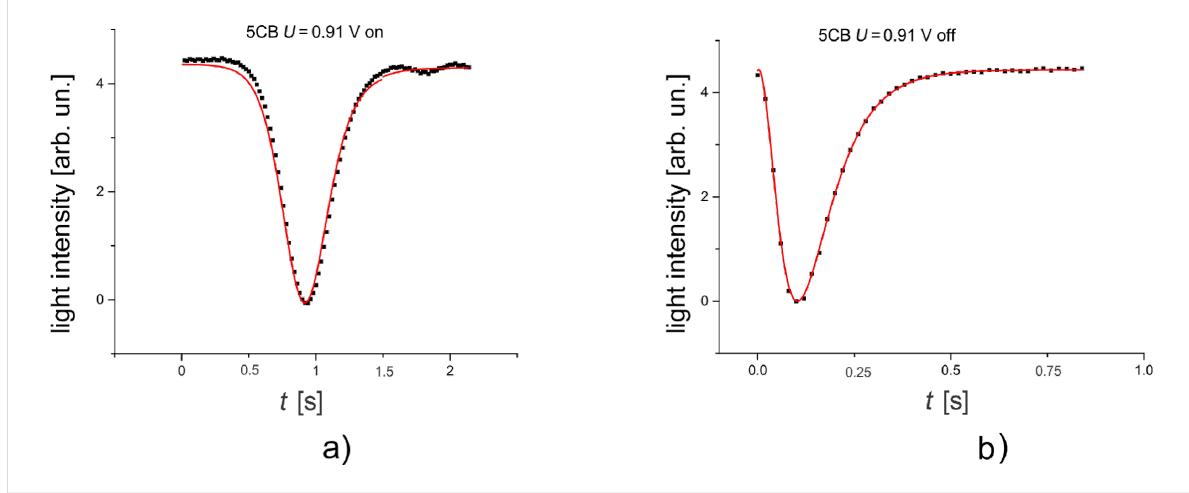
Figure 7: Variation of the intensity of a light beam traversing a cell containing pure 5CB. a) The field is switched on, b) the field is switched off.